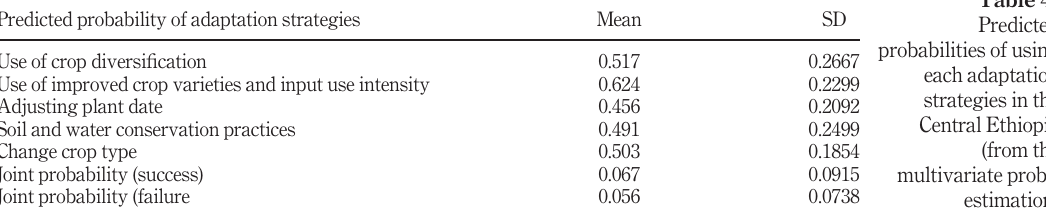
probabilities of using each